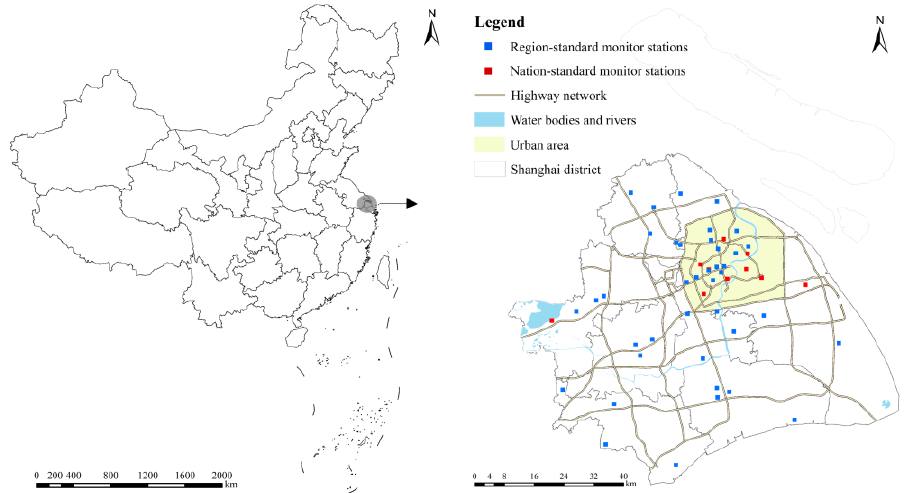
Figure 2. Study area and monitor distributions.